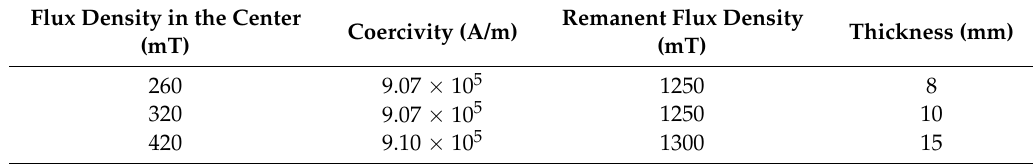
Table 1. Magnet parameters in the FEM